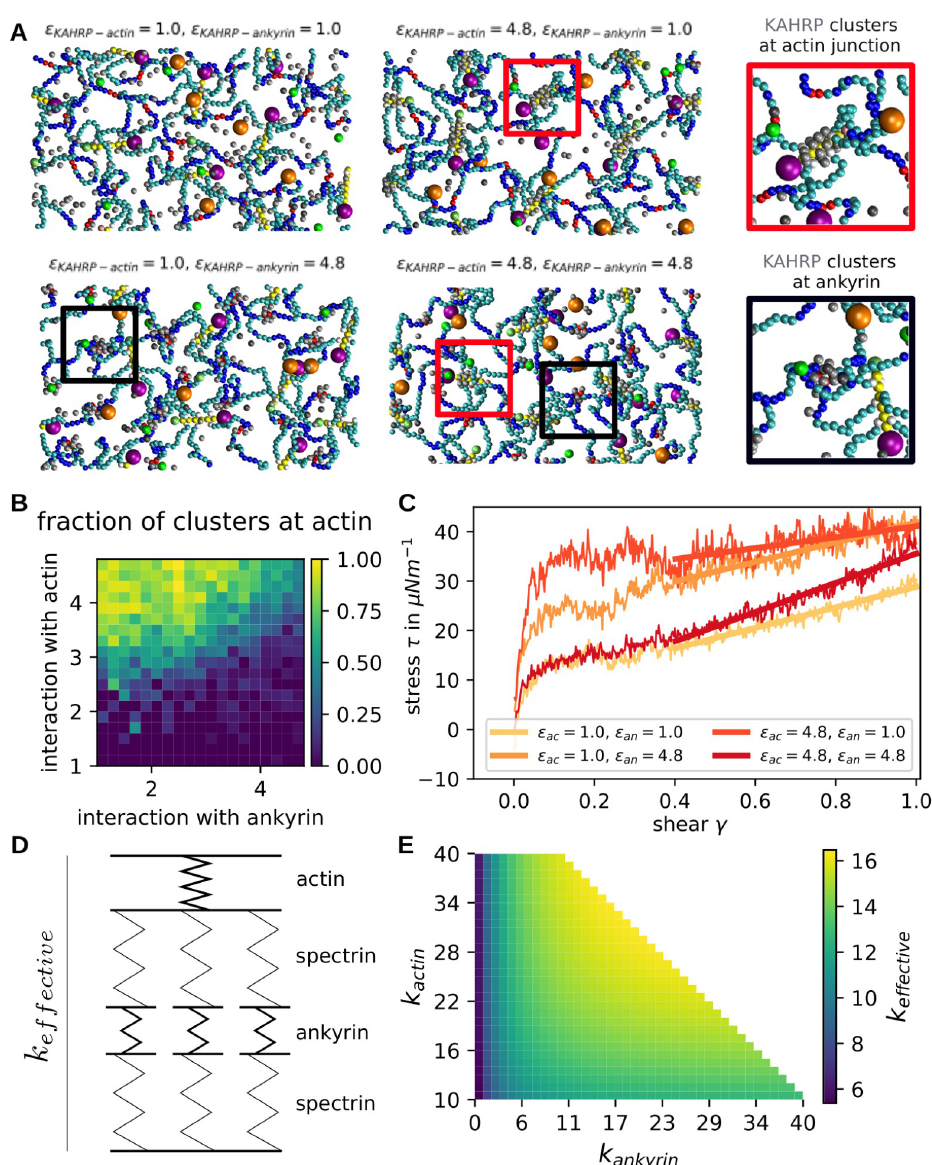
Fig 6. Effect of KAHRP clusters in actin-spectrin network. (A) Snapshots of equilibrated networks for the interaction energies indicated above each image. KAHRP particles are shown in grey and some KAHRP clusters are indicated by rectangles and shown as zoom-ins. G-actin particles are not shown here. (B) Fraction of clusters that are located at actin filaments in contrast to other cytoskeletal subunits. The value is calculated for different interaction energies with actin and ankyrin. (C) Shear response of KAHRP containing networks for different KAHRP positioning. (D) A simple spring model was set up to understand the shear-reasponse of the KAHRP-containing cytoskeletal networks. (E) The effective spring constant is plotted according to our spring